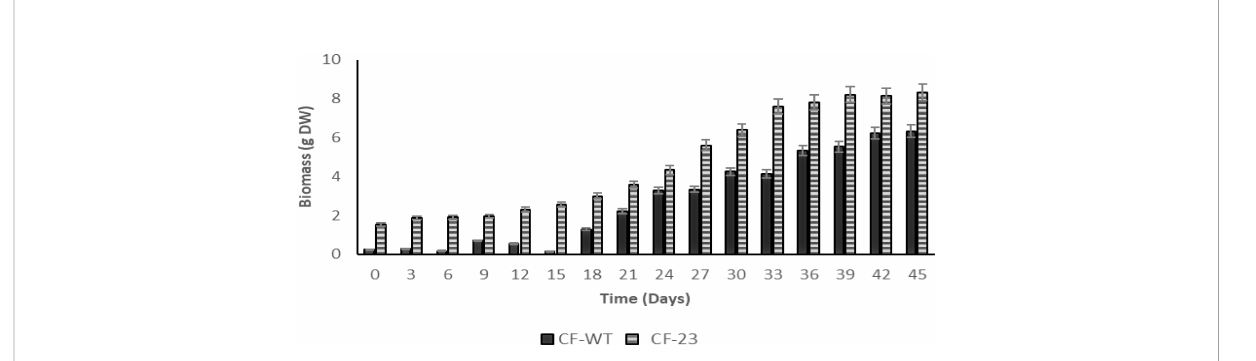
FIGURE 1 Growth of C. papaya CF-23 and CF-WT callus lines in B5 medium + 2,4 D:KIN, 2:2 mg/L in the dark. Data are expressed as mean ± SD of three independent experiments. Signi fi cant differences between CF-WT and CF-23 were observed, P = 0.02938047, a = 0.05 for ANOVA and Tukey ’ s test ( P <